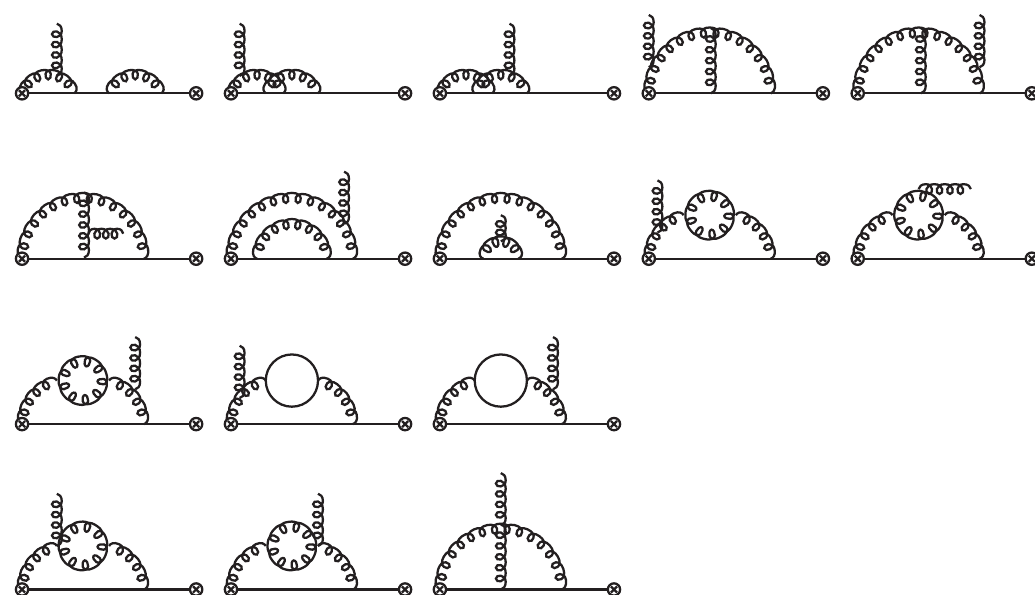
Figure 3: Feynman diagrams contributing to the jet function at two-loop order in light-cone gauge. These diagrams involve three (first rows) and four point interac- tions (last row) of gluons. As previously, the fermion in the diagrams in the third row can run in both